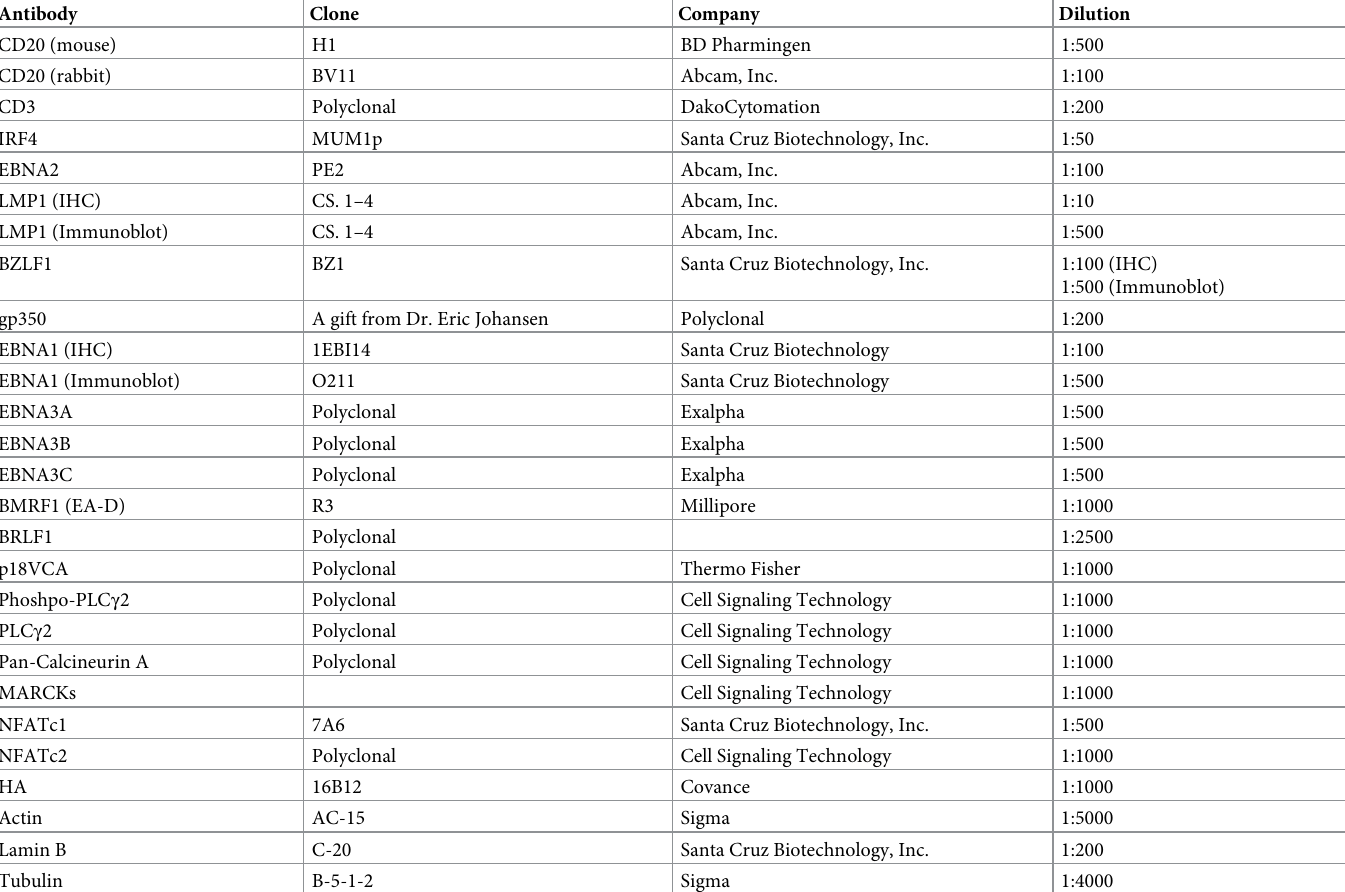
Table 3. The list of antibodies used in this study for IHC and immunoblot analysis. Antibody